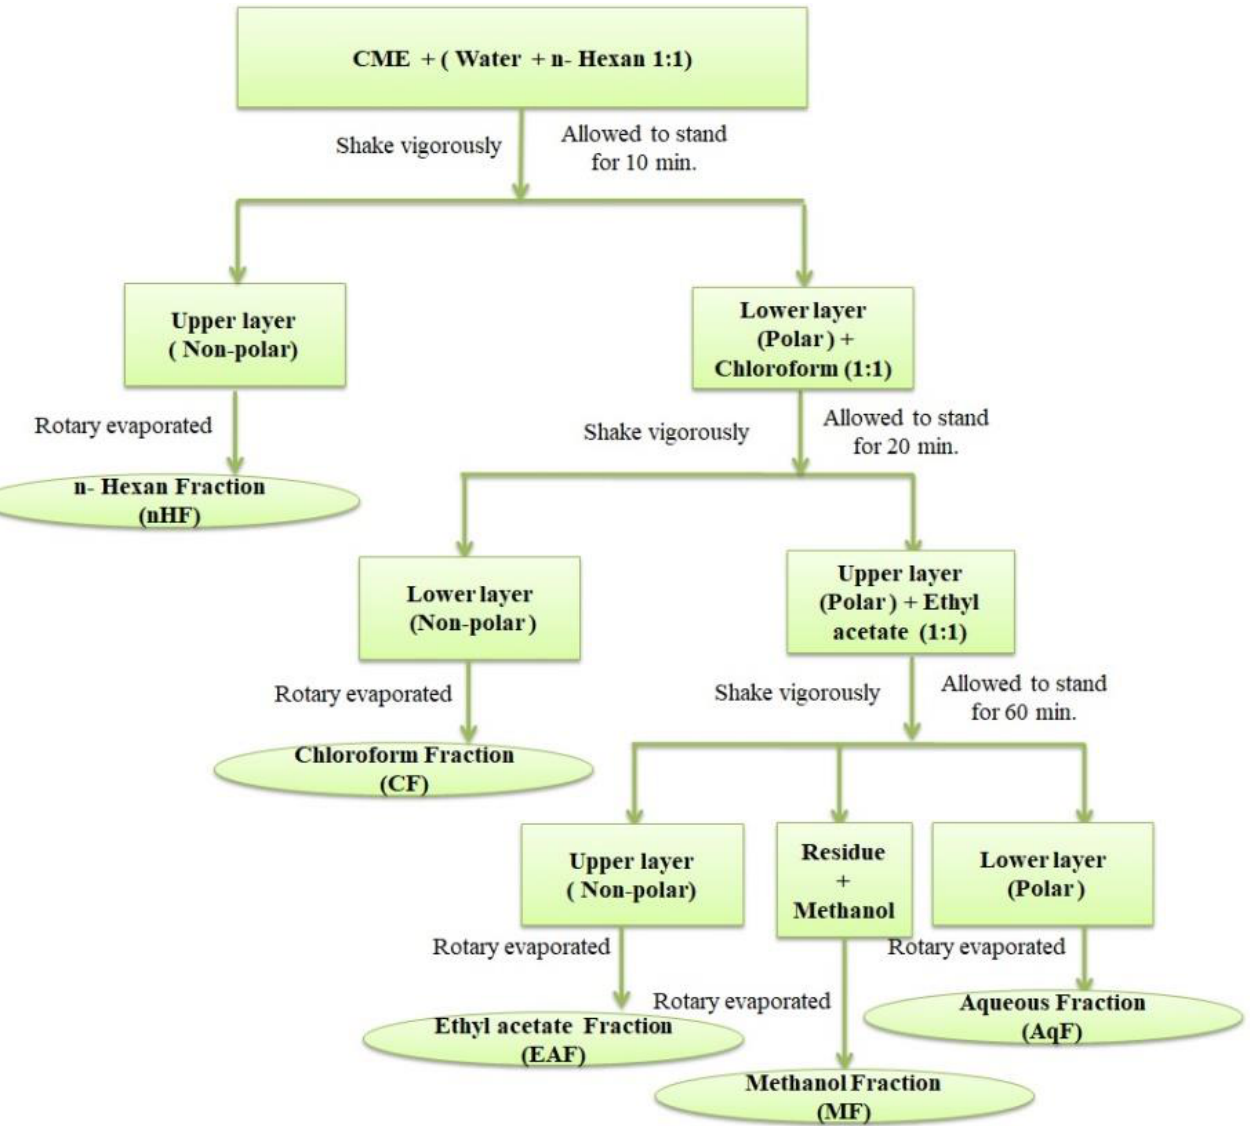
Figure 2. Fractionation scheme: a flow diagram representing the polarity-based solvent–solvent fractionation of crude methanolic extract (CME) of Dryopteris ramosa .